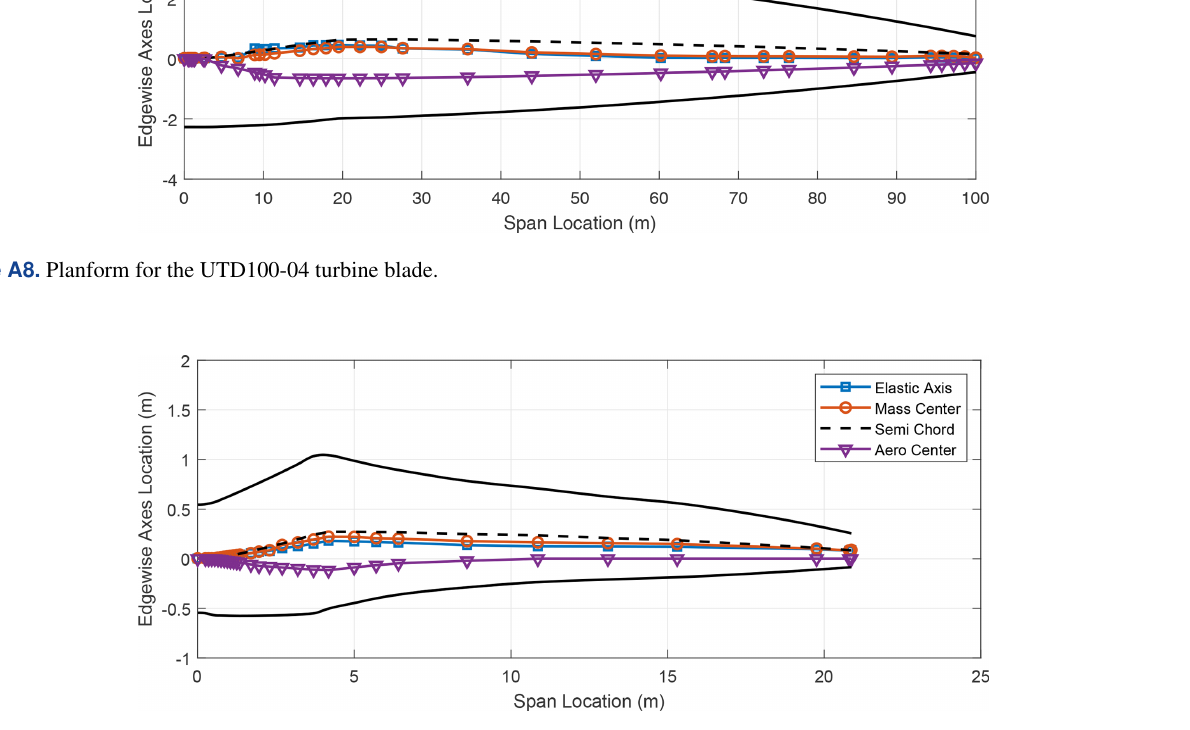
Figure A9. Planform for the SUMR-D turbine